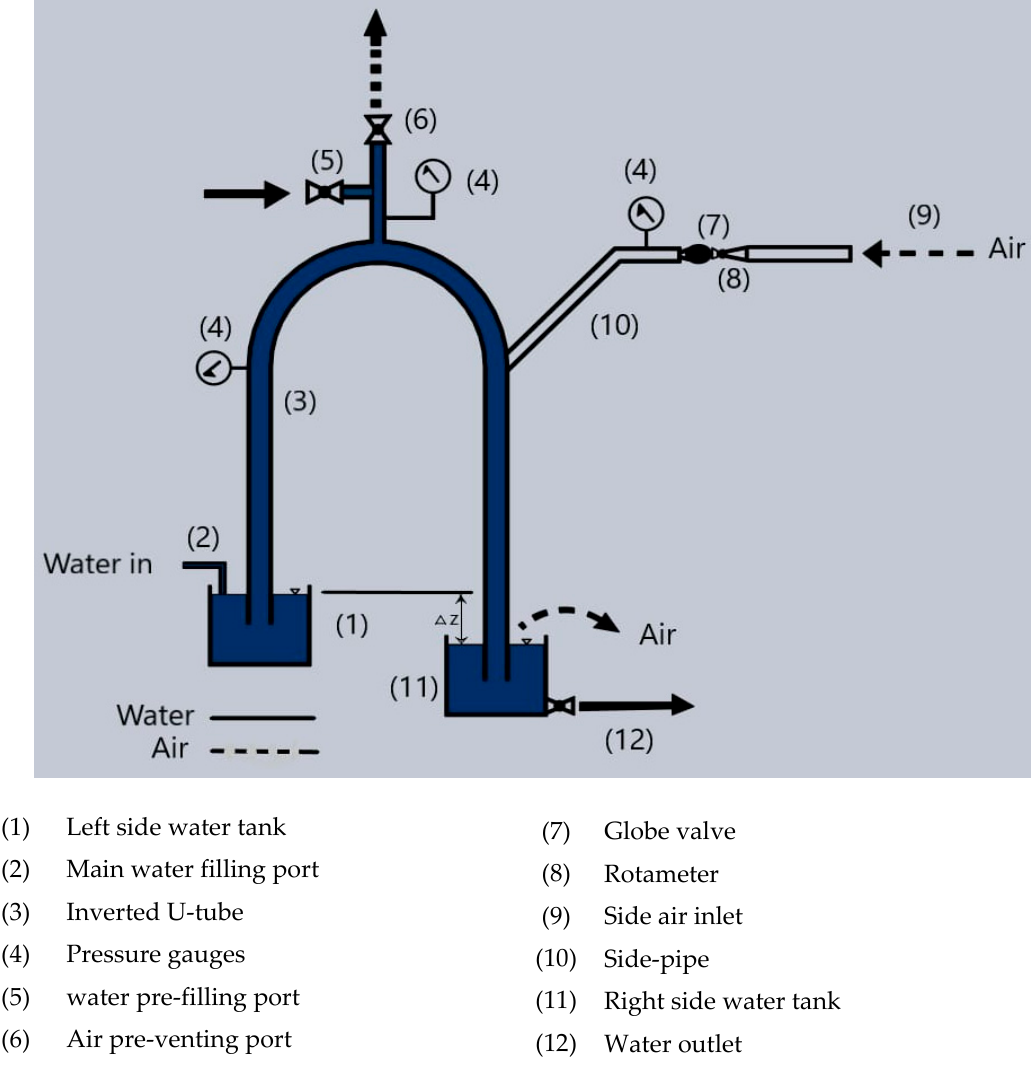
Figure 1. Experimental test rig and its components.